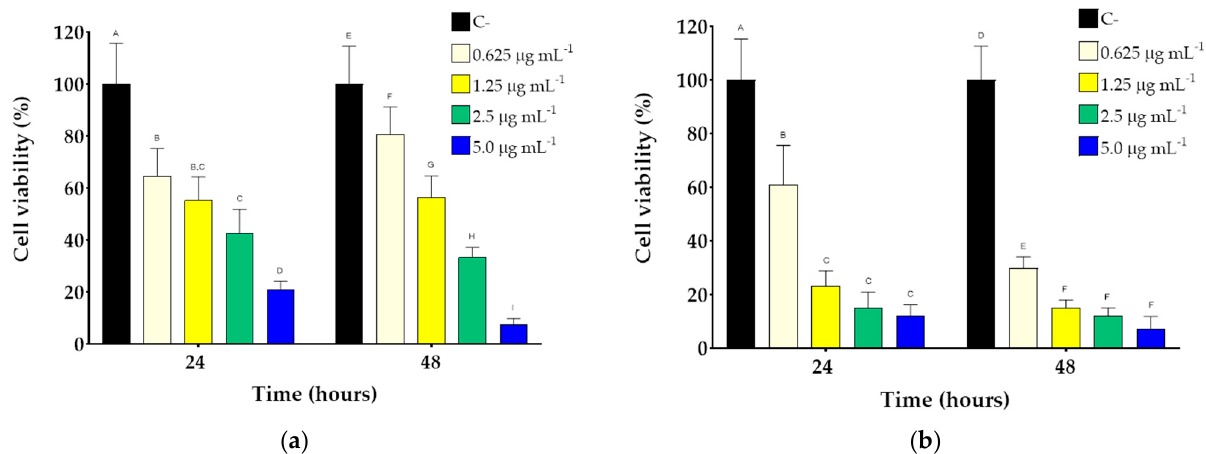
Figure 7. Cell viability of BALB/3T3 ( a ) and MDA-MB231 cells ( b ) treated with DOX@HNPs (drug concentration ranging from 0 to 5 μ g/mL) after 24 and 48 h of culture. Within each group, different letters denote statistical differences for p < 0.05, n = 5.